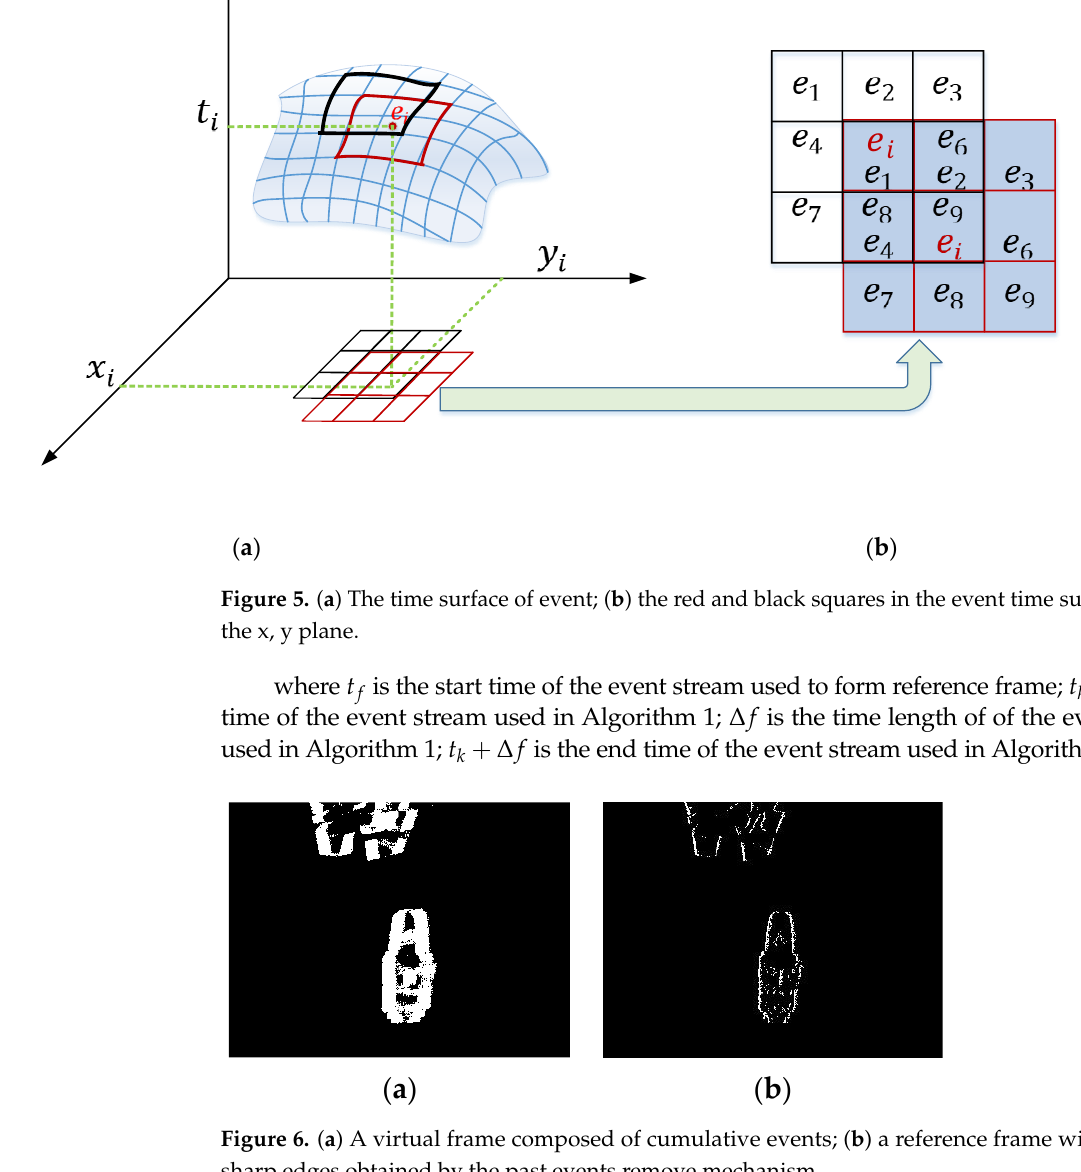
Figure 5. ( a ) The time surface of event; ( b ) the red and black squares in the event time surface map to the x, y plane.